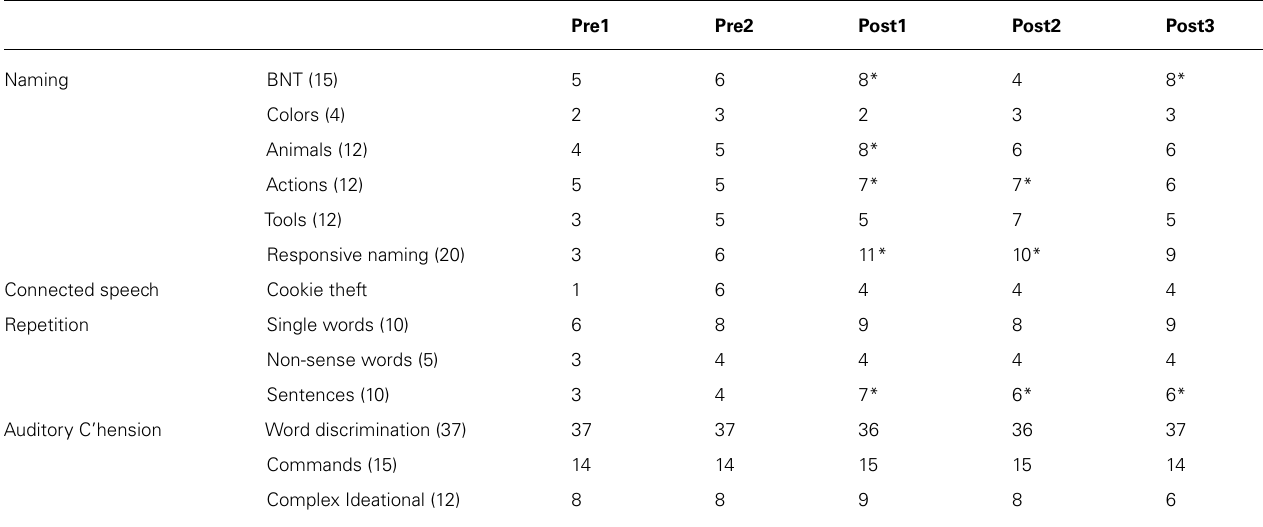
Table 4 | BDAE scores for Participant